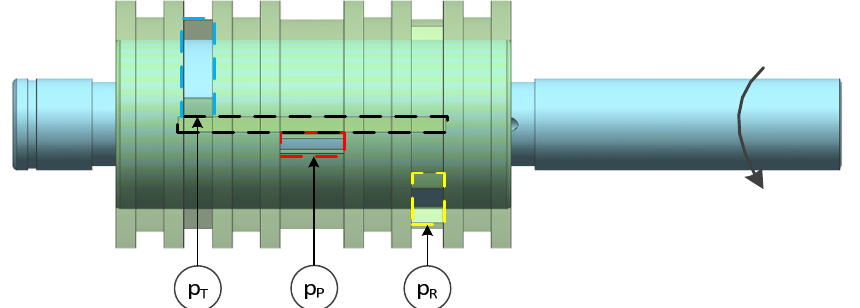
Figure 3. Schematic assembling diagram of the sleeve and the spool. The blue rectangle represents the back pressure window; the red rectangle, the peak pressure window; the yellow rectangle, the rated pressure window; the dark rectangle, the slot on the rotary spool.